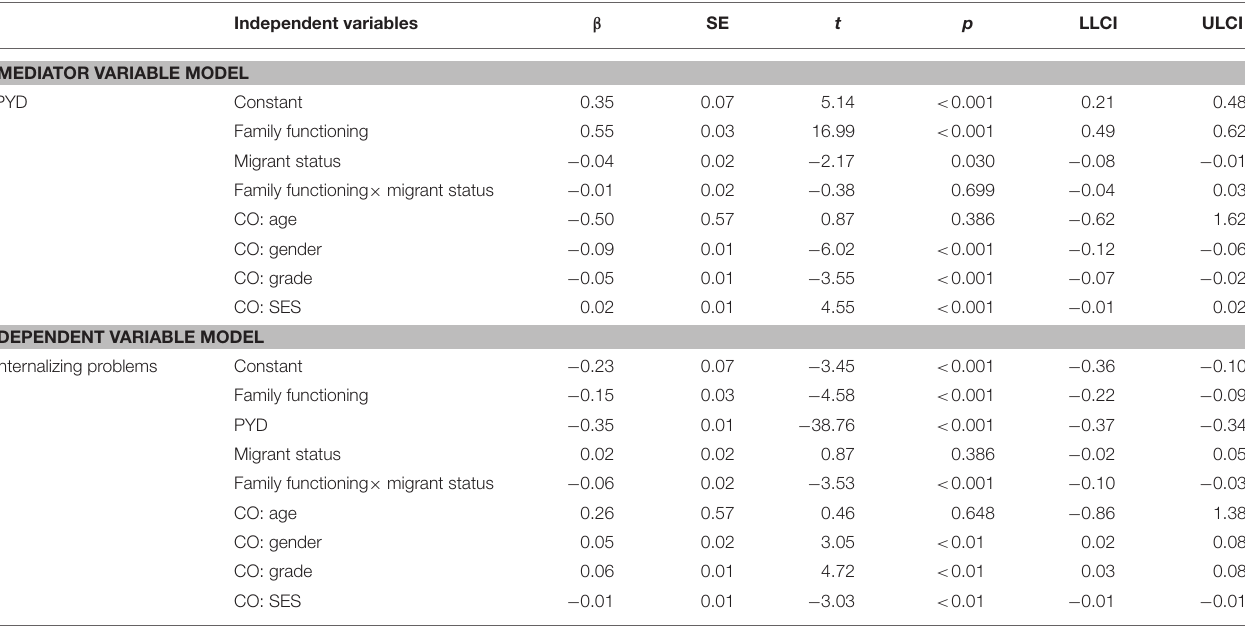
TABLE 4 | Testing the moderated mediation effects of family functioning on internalizing